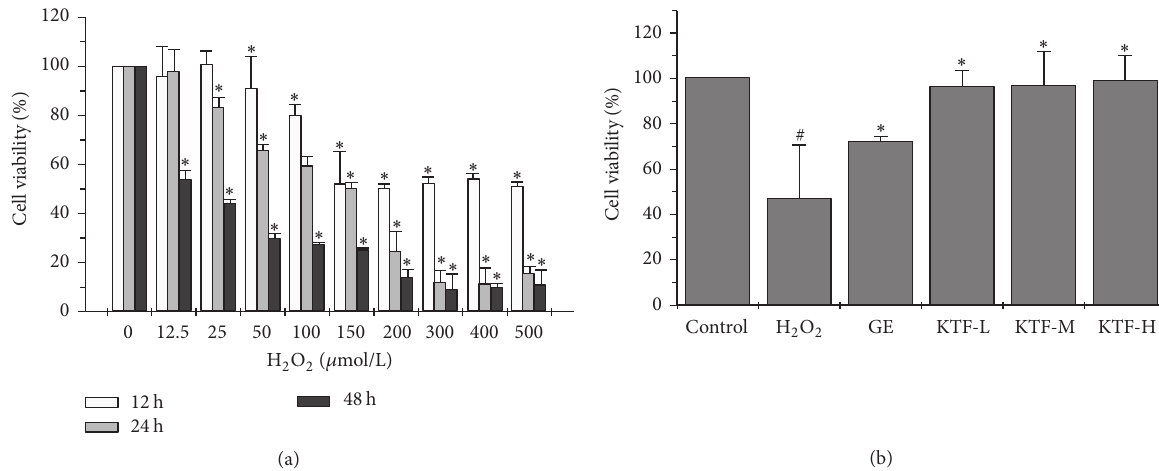
Figure 1: The damage effects of H 2 O 2 on MES23.5 cells and the protective effects of KTF against oxidative stress were evaluated using MTT assay. (a) Effects of different concentrations of H 2 O 2 treatment on cell damage. MES23.5 cells were treated with 12.5, 25, 50, 100, 150, 200, 300, 400, and 500 𝜇 Mol/L H 2 O 2 for 12, 24, and 48h. (b) Protective effects of different concentrations of KTF treatment on H 2 O 2 -induced cell damage. Treatment of KTF resulted in increase of MES23.5 cells viability after H 2 O 2 addition. MES23.5 cells were incubated with GE (12.5 𝜇 g/ml) or KTF (3.125, 6.25, 12.5 𝜇 g/ml) for 24 h after the addition of H 2 O 2 . The cell viability was measured with MTT. Data are expressed as mean ± SD (standard deviation) in three independent experiments. # 𝑃 < 0.05 compared to the control group. ∗ 𝑃 < 0.05 compared to the H 2 O 2 -treat